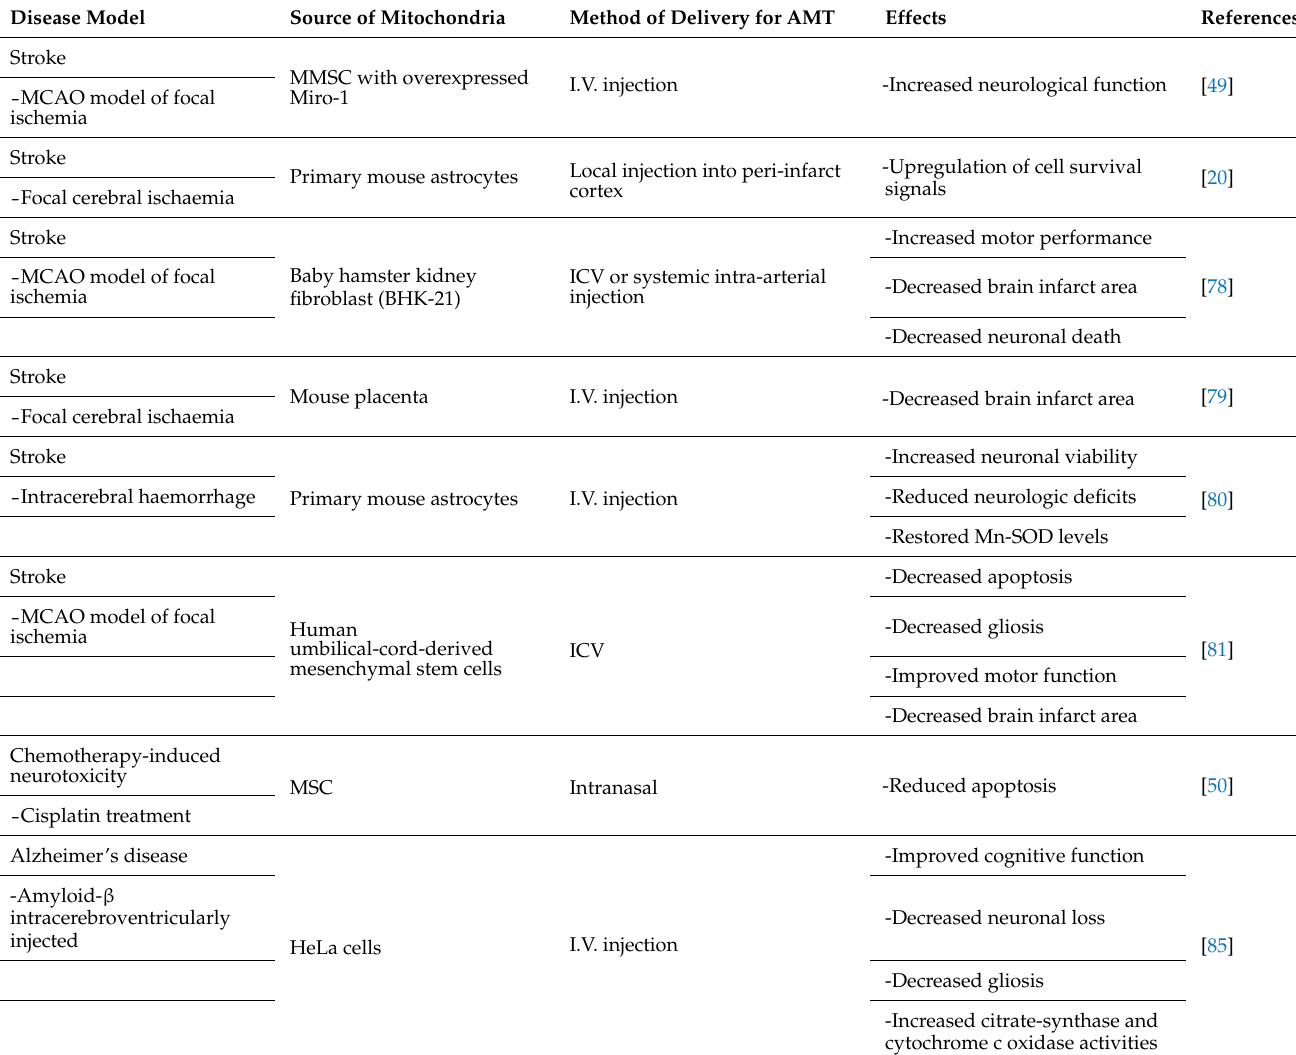
Table 2. In Vivo Artificial Mitochondrial Transplantation in Brain Injury and Disease. Disease